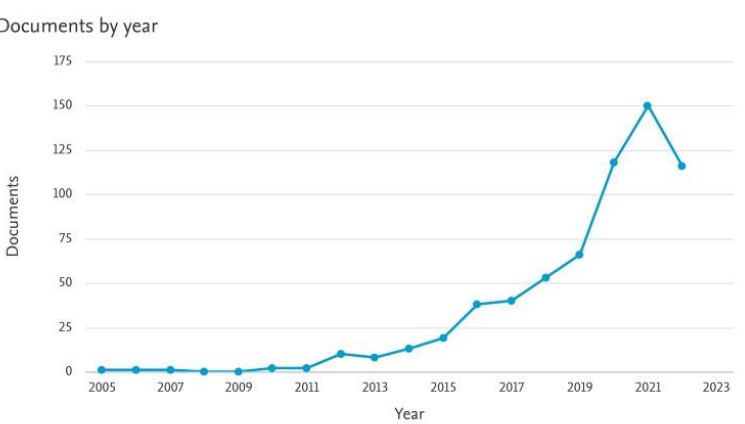
Figure 2. Scientific publications registered in Scopus as of 22 September 2022, using as search descriptors [(Pedagogical Models AND Physical Education)] OR [(Pedagogical Model AND Physical Education)].